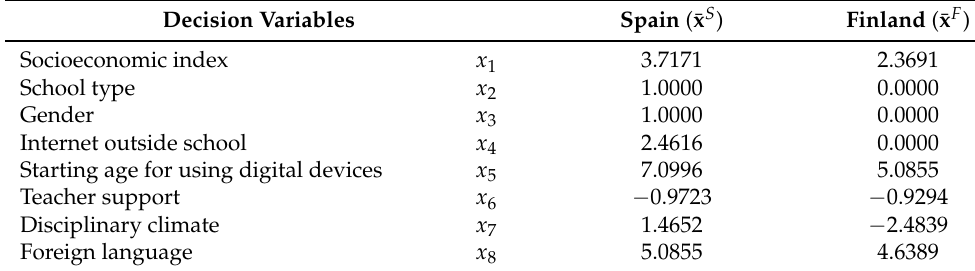
Table 8. Possibly efficient solutions obtained to problems (3) and